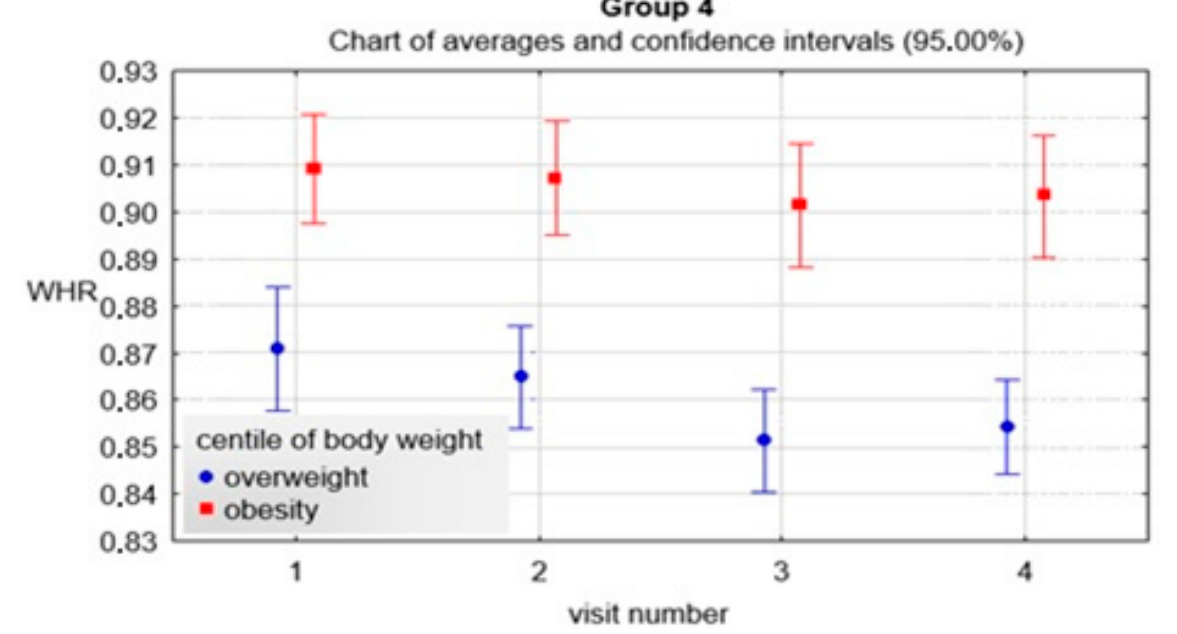
Figure 2. BMI in children with overweight and obesity at consecutive visits.